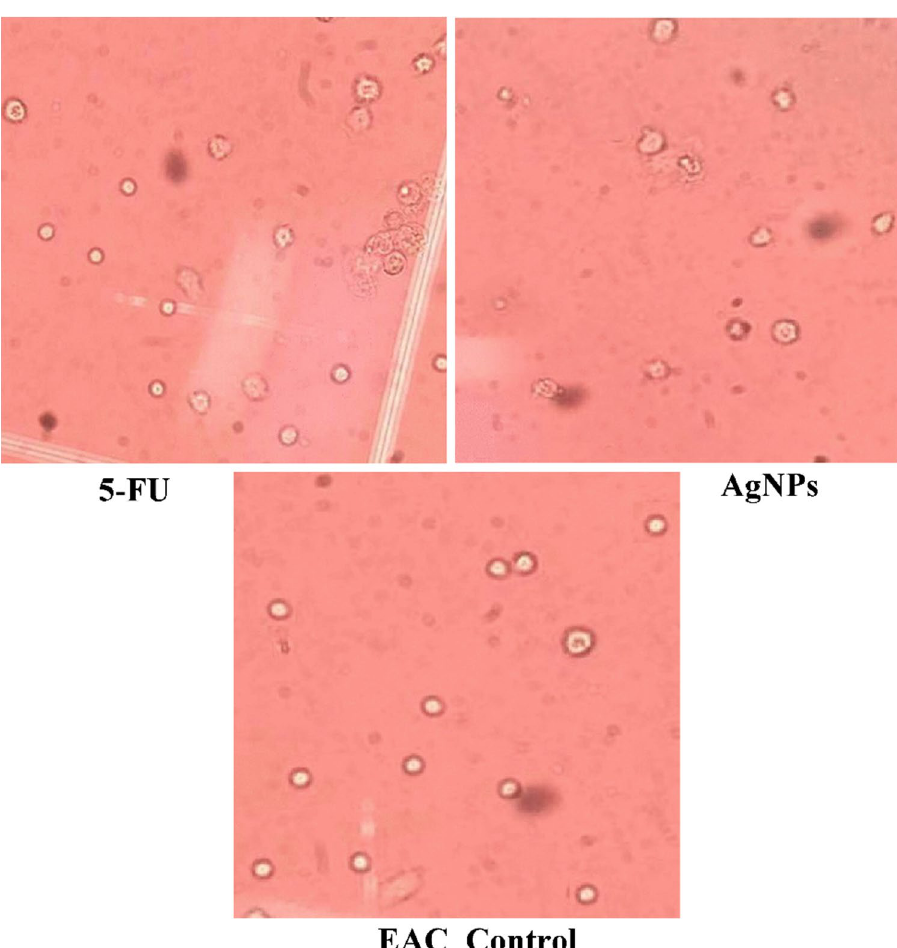
Figure 13. Microscopy images demonstrate the cytotoxic effect of AgNPs and 5-FU on EAC cells, cell damage by AgNPs due to loss of cell membrane integrity and